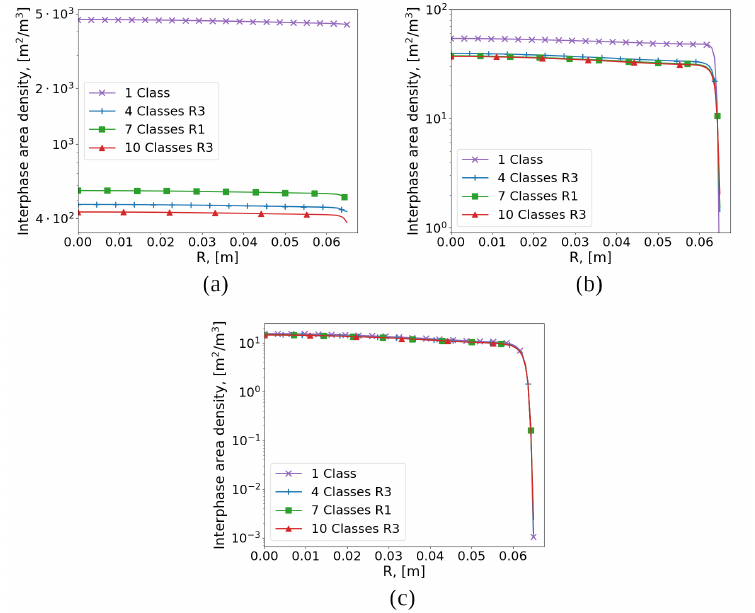
Figure 5. Radial profiles of the interfacial area density in the reference cross-section (see Figure 1) for different characteristic bubble sizes: ( a ) M = 0.25 mm; ( b ) M = 0.5 mm; ( c ) M = 1.0